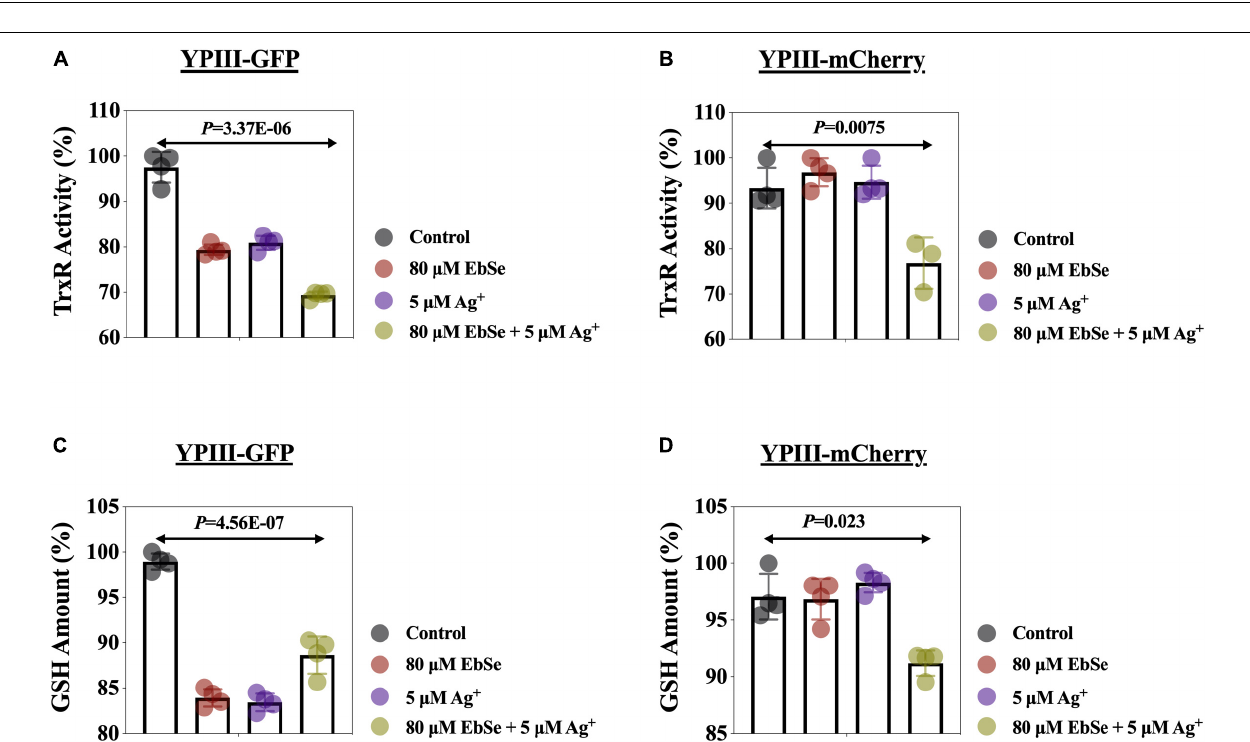
FIGURE 7 | EbSe-Ag + inhibits TrxR activity and depletes GSH in YpIII. YpIII-GFP and YpIII-mCherry were cultured to A 600 of 0.4 and treated with EbSe-Ag + . DTNB assay was used to detect the TrxR activity and GSH amount. (A,B) At 30 min; (C,D) 0–5 min slope; (A,C) YpIII-GFP; (B,D) YpIII-mCherry.